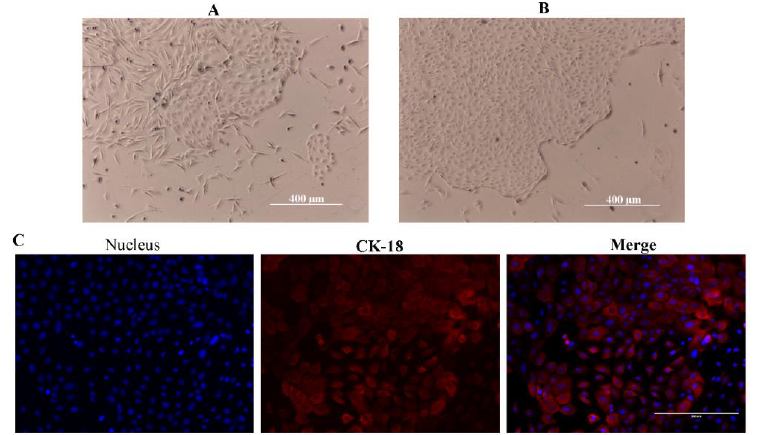
Figure 2. The isolation of goat mammary epithelial cells. ( A ) MECs and fibroblasts were emigrated from the cultured mammary tissue. ( B ) Purified MECs. ( C ) The immunofluorescence identification of MECs through the biochemical marker of CK-18.